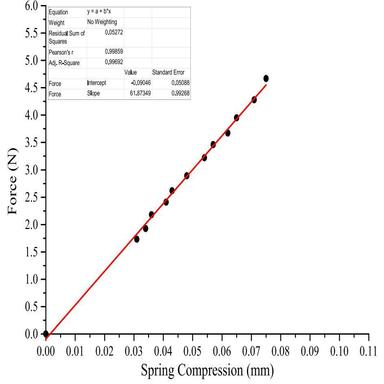
Relationship between spring force and compression.